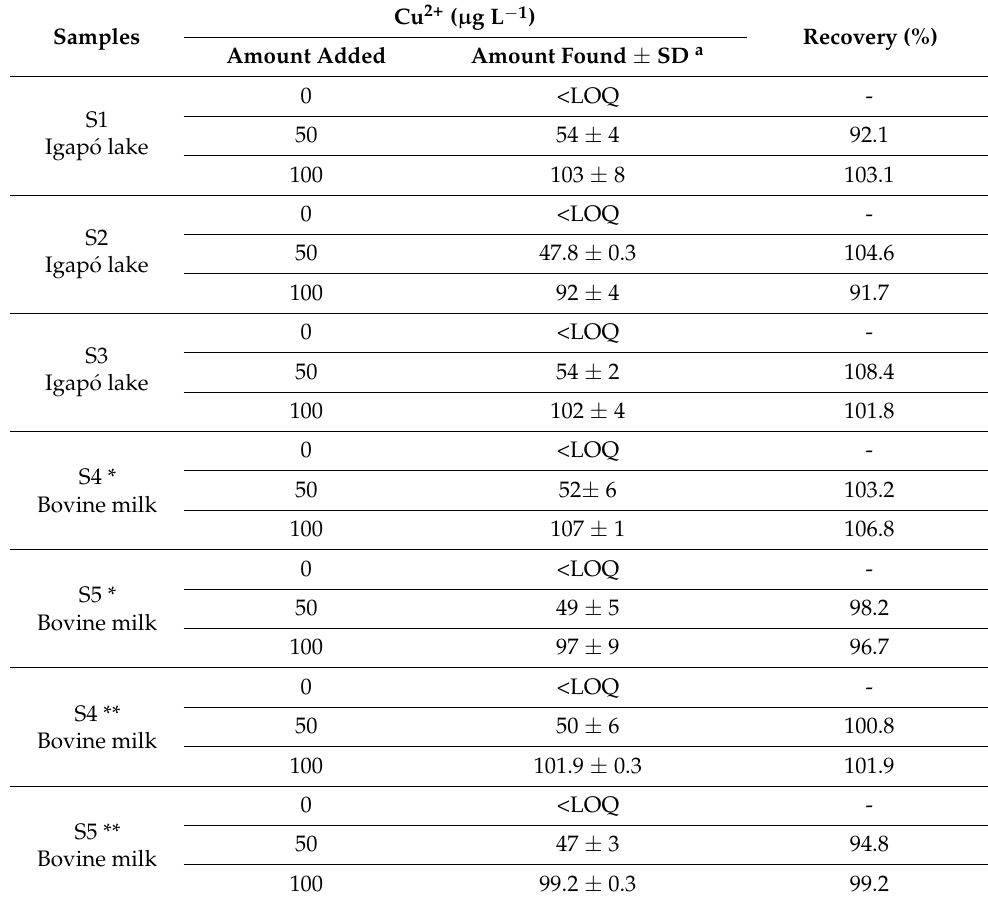
Table 2. Values of Cu 2+ concentration found in samples of water and bovine milk using FIA- FAAS